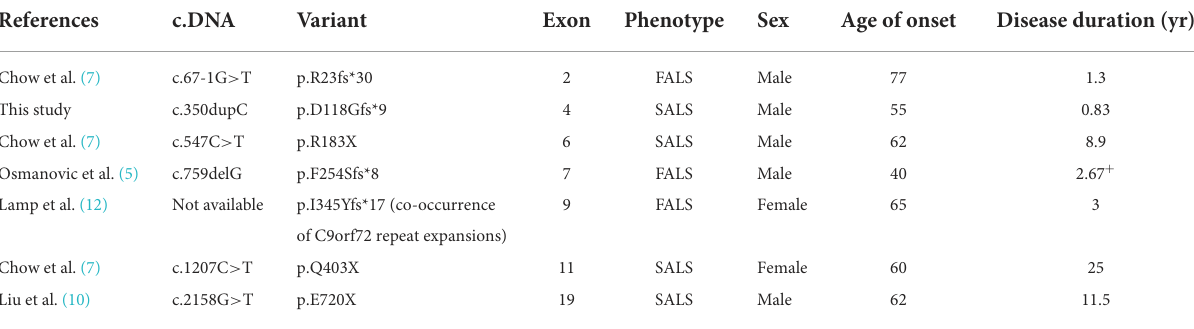
TABLE 1 Clinical phenotypes of frameshift variants and non-sense variants of the FIG4 gene identified in ALS patients.